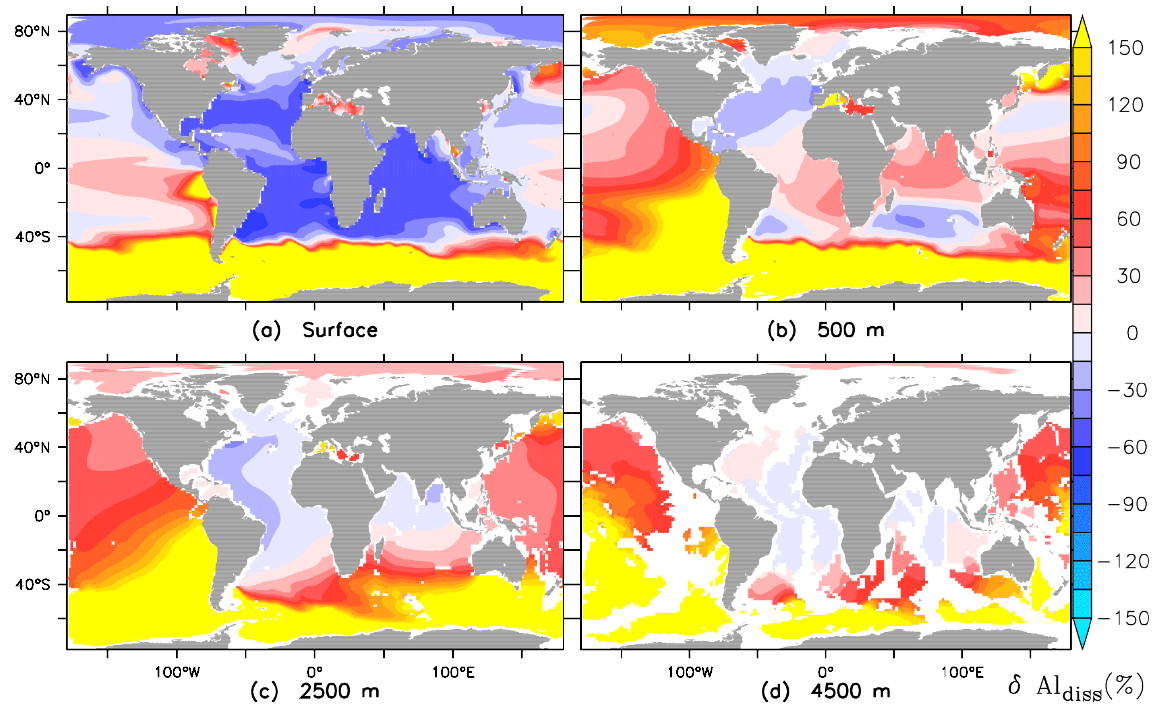
Figure 11. Result of a 500 yr simulation with incorporation (no limitation, i.e. R Al/Si = [ Al diss ] / [ Si diss ] ) and a decreased scavenging parti- = k = 28 × 10 3 dm 3 mol − 1 (IncorpLowScav). Relative difference of [ Al tion coefficient k 0 d / 4 d